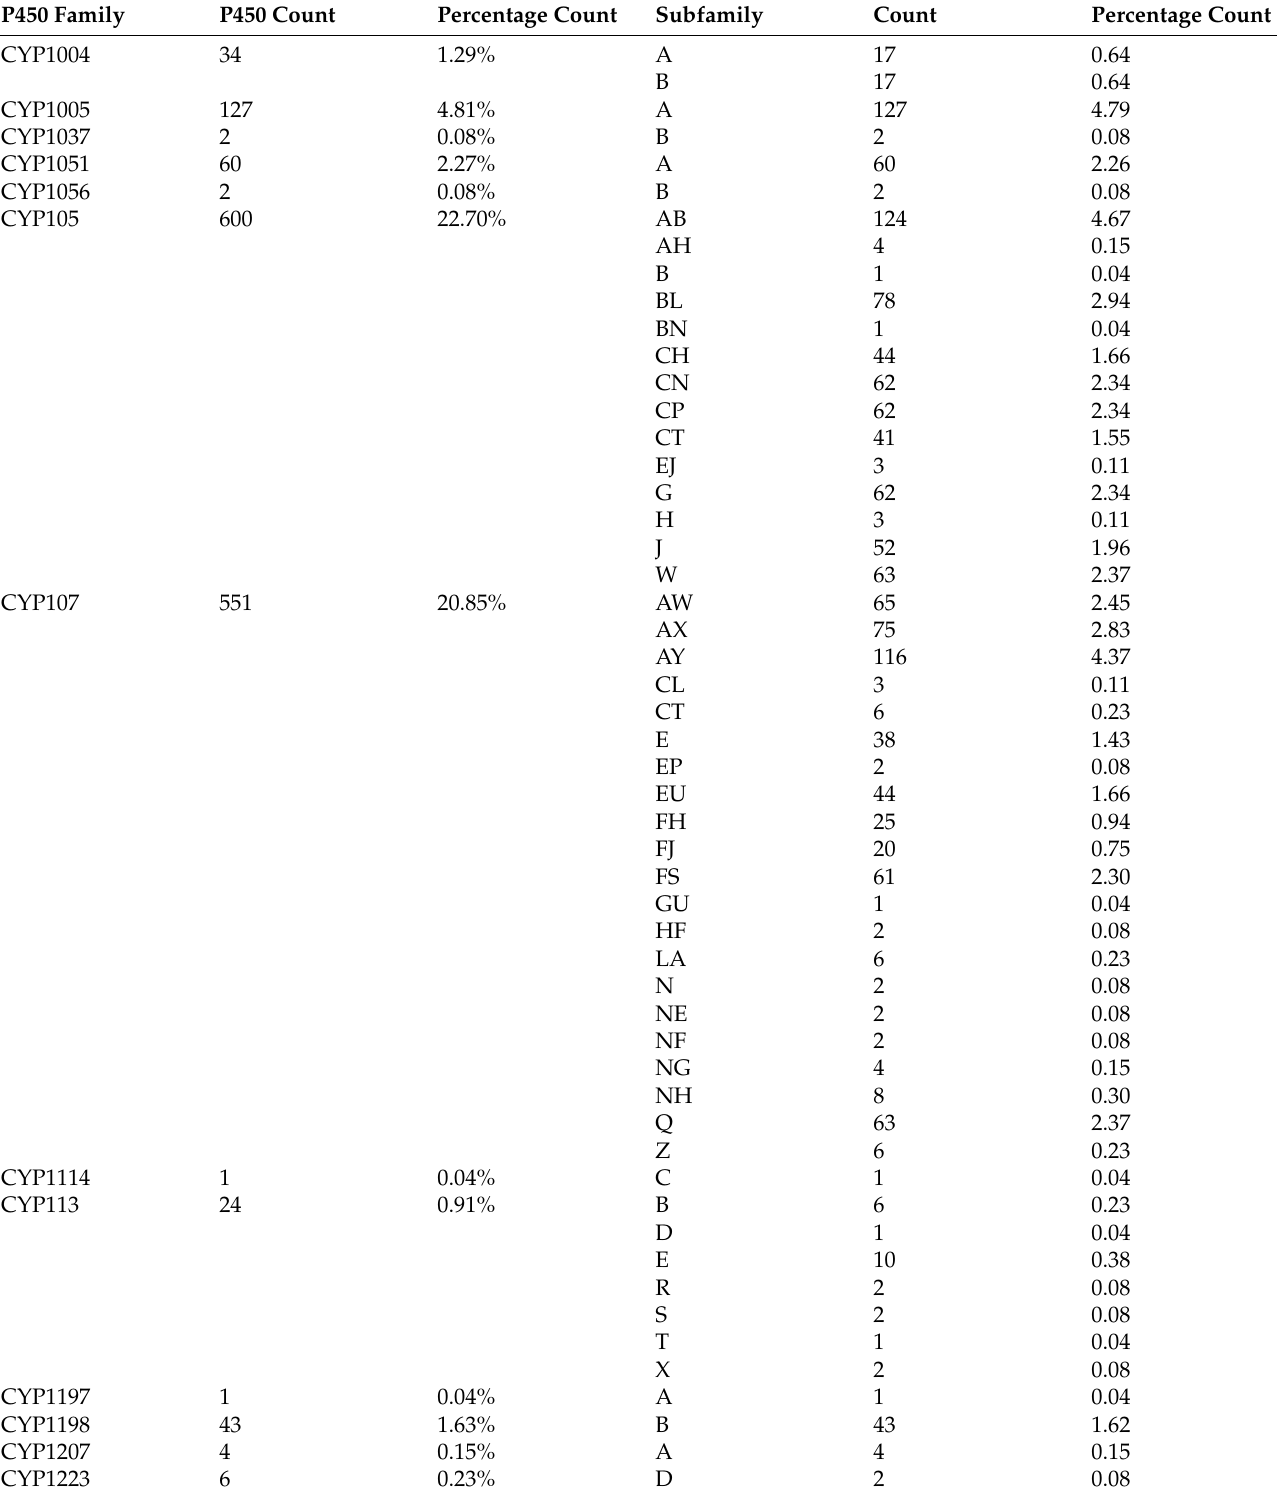
Table 3. Comparative analysis of P450 families and subfamilies in Salinispora